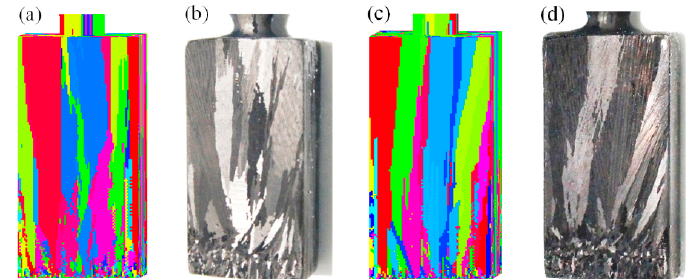
Figure 4. Comparison of microstructures in real starter block of spiral selector from experiment and simulation: ( a ) simulation result (front side); ( b ) experimental result (front side); ( c ) simulation result (reverse side) and ( d ) experimental result (reverse side); starter block dimensions: 10 mm × 10 mm × 30 mm.